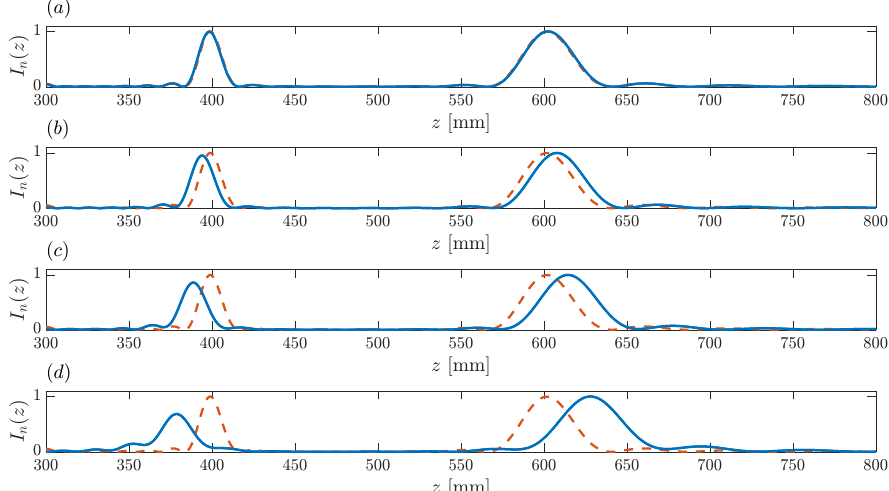
Figure 9. Bifocal ZP focusing profiles vs. axial coordinate for different design frequencies. Blue solid line: ( a ) f = 5 MHz, ( b ) f = 1 MHz, ( c ) f = 500 kHz, ( d ) f = 250 kHz. Dashed red line corresponds to the initial design example with f = 10